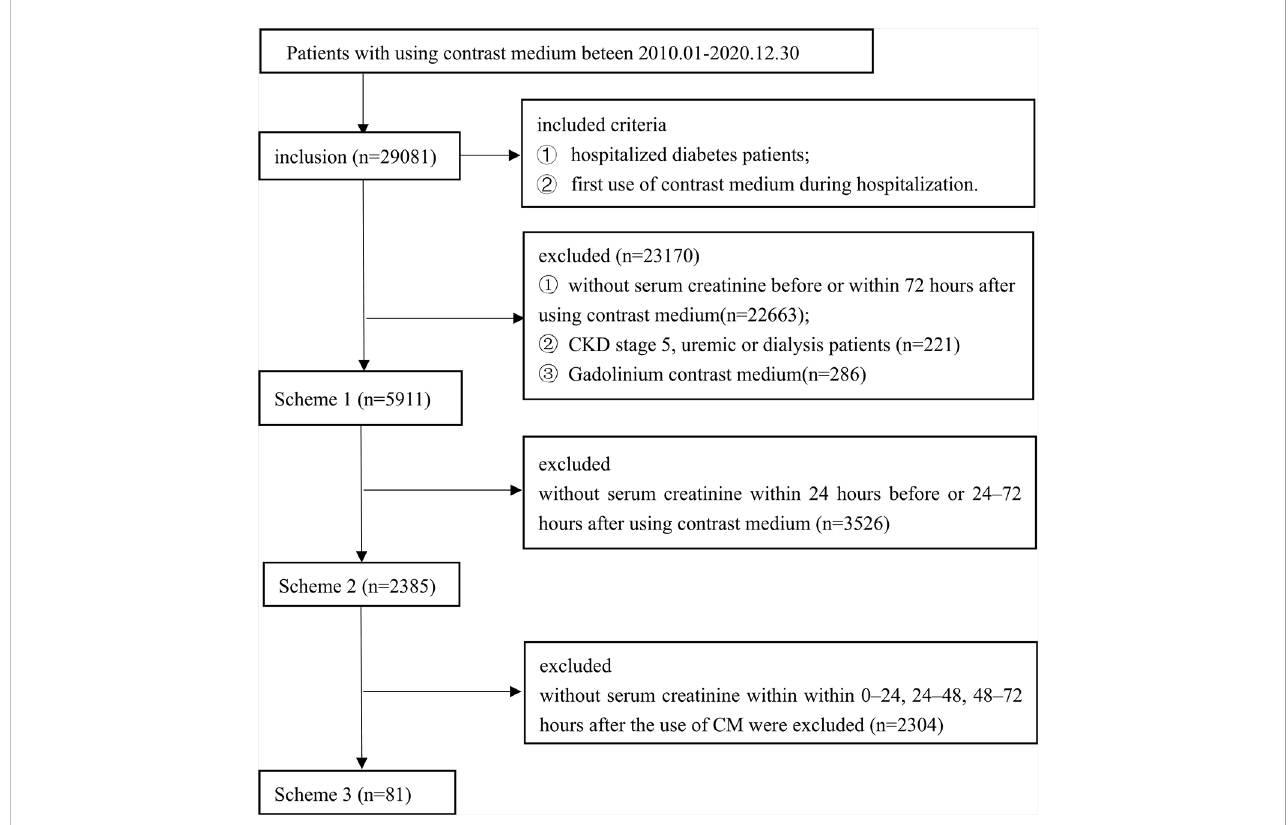
FIGURE 1 Flow diagram of included studies. Three different serum creatinine detection standard schemes: Scheme 1 (n=5911), SCr was detected before and within 72 h after using contrast medium; Scheme 2 (n=2385), SC was detected within 24 h before and within 24-72 h after using contrast medium; and Scheme 3 (n=81), SCr was detected within 24 h before and within 0-24, 24-48, and 48-72 h after using contrast